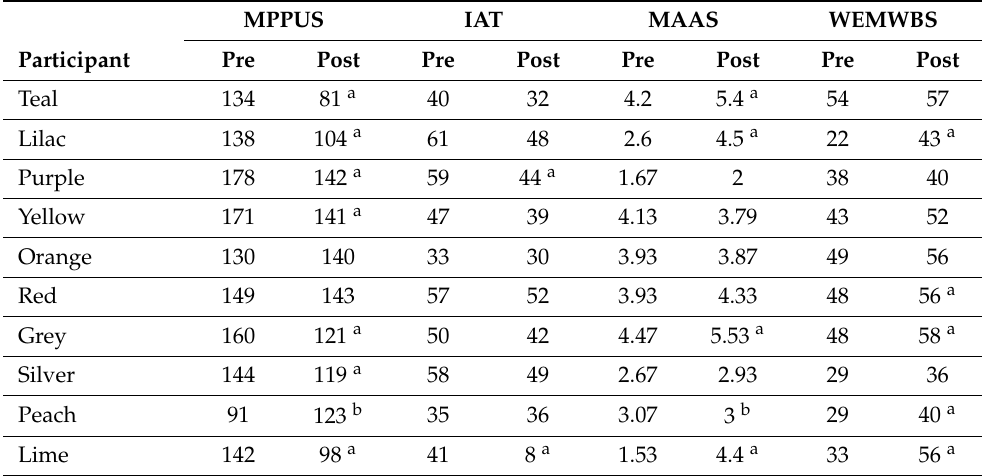
Table 3. Pre- and post-intervention scores on MPPUS, IAT, MAAS, and WEMWBS. MPPUS IAT MAAS